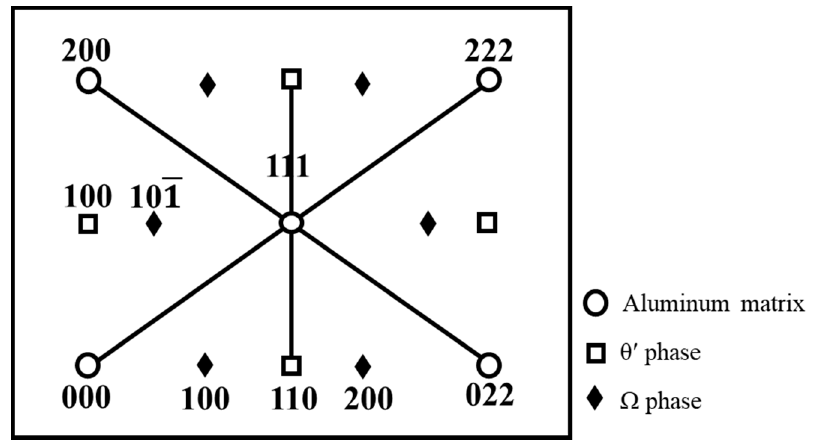
Figure 4. Schematic diagram of the diffraction pattern of θ ’ and Ω strengthening phases along [011] α zone in A201-T7 alloy.